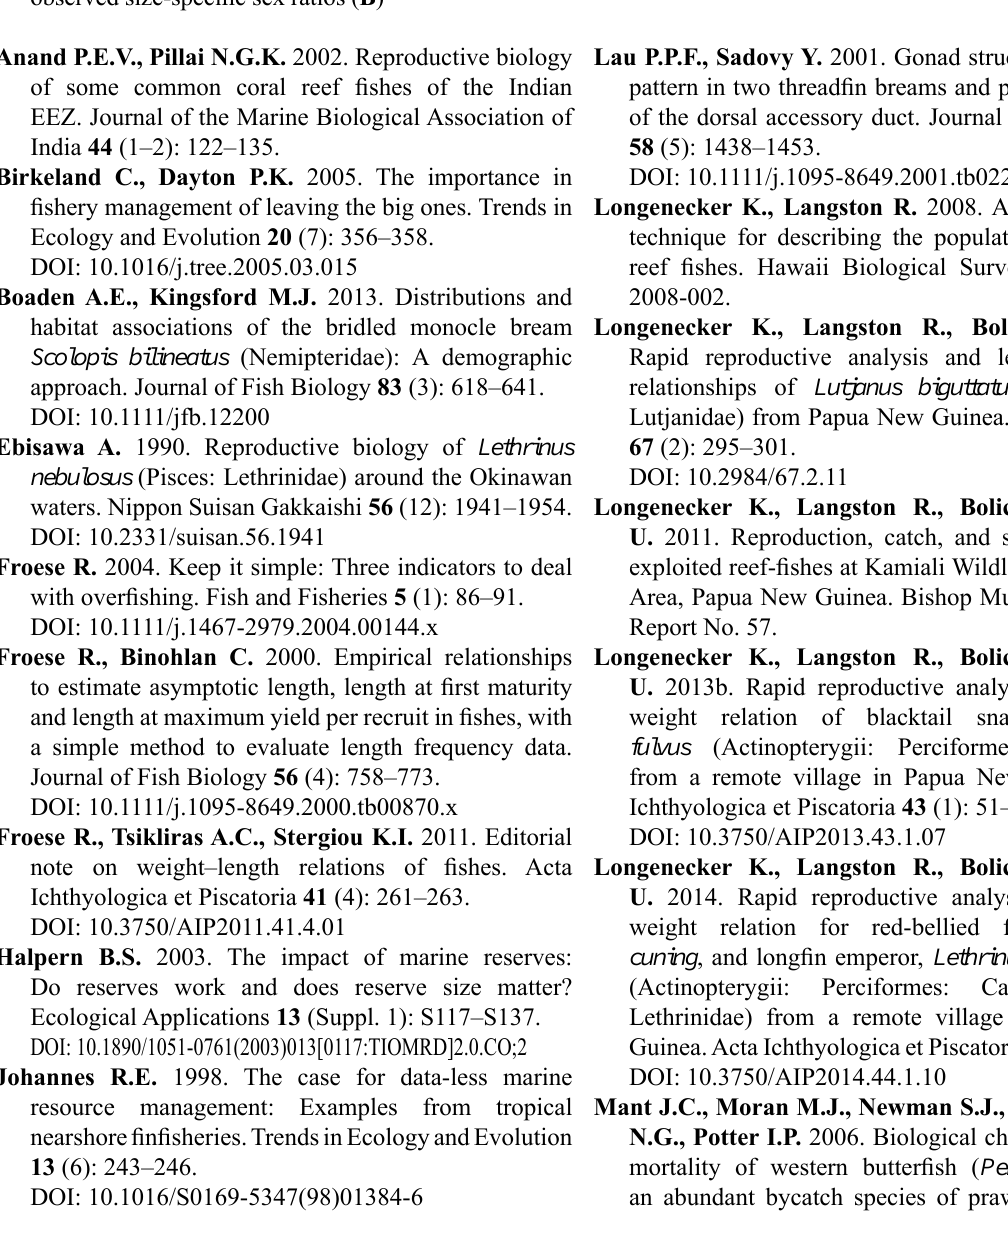
Fig. 5. The infl uence of size-specifi c sex ratios on population-level patterns of egg production: the overall 1 : 1 sex-ratio (dashed curve) in Parupeneus indicus appears as expected—The largest individuals are responsible for the majority of egg production, however smaller individuals are responsible for the majority of egg production (arrow) when size- specifi c sex ratios are considered (solid curve) ( A ); Patterns of egg production in Rhinecanthus verrusosus , given observed size-specifi c sex ratios ( B